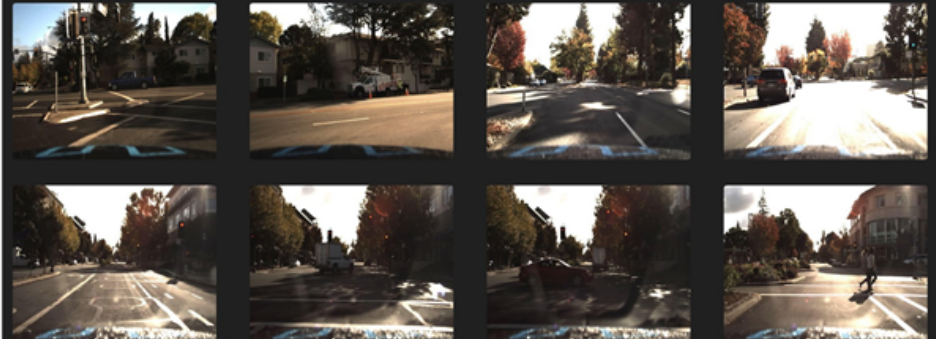
Figure 5. A snapshot of several images from the Udacity dataset.